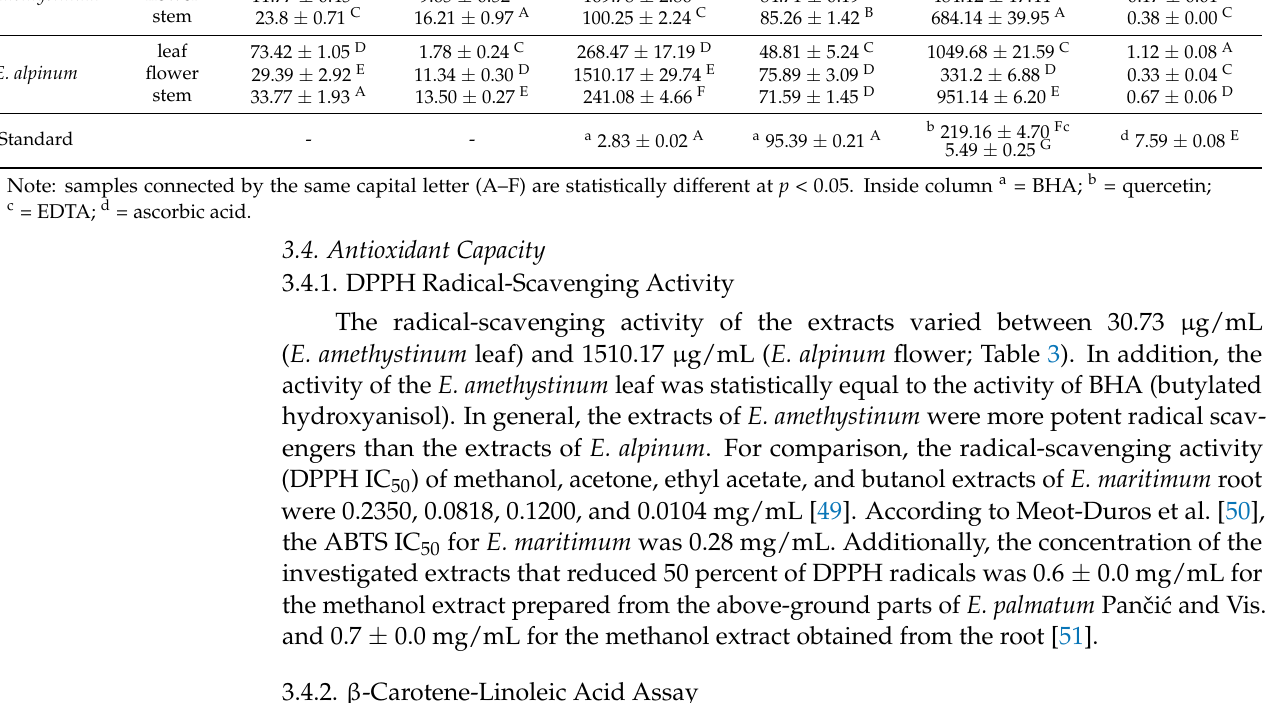
Table 3. Content of total phenols (TP) and flavonoids (TF), radical scavenging (EC 50 ), and antioxidant activity obtained in β -carotene-linoleate assay (ANT), metal chelating activity (ChEC of E. amethystinum and E. alpinum extracts. Values are calculated as means ± SD. N = 3.